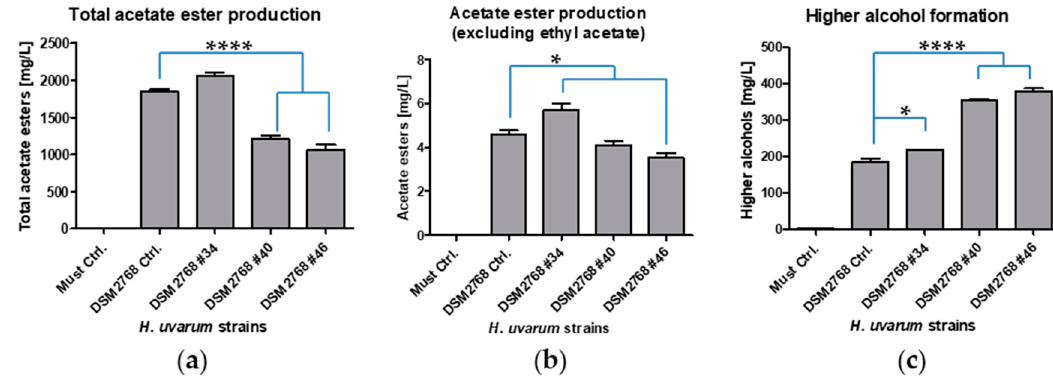
Figure 3. Acetate ester production and formation of higher alcohols during fermentation. ( a ) Total acetate ester production (mg/L) including ethyl acetate, isoamyl acetate, 2-methylbutyl acetate, hexyl acetate, and 2-phenylethyl acetate; ( b ) Acetate ester production (mg/L) excluding ethyl acetate; ( c ) The formation of respective higher alcohols (mg/L) including isoamyl alcohol, 2-methyl-1-butanol, hexanol, and 2-phenyl ethanol after three days of fermentation of Müller-Thurgau must with H . uvarum DSM2768 for comparison (DSM2768 Ctrl), DSM2768 #34 (WT/ Δ ), DSM2768 #40 ( Δ / Δ ), and DSM2768 #46 ( Δ / Δ ). Pure must without the addition of yeasts served as a negative control (Must Ctrl). Total ester production was measured via HS-SPME-GC-MS analysis while acetic acid production was measured via high performance liquid chromatography (HPLC) analysis. Data are the mean of three independent experiments ± SEM, 1-way ANOVA, Bonferroni’s multiple comparison test, * p < 0.05 and **** p < 0.0001. Error bars indicate the standard deviation.